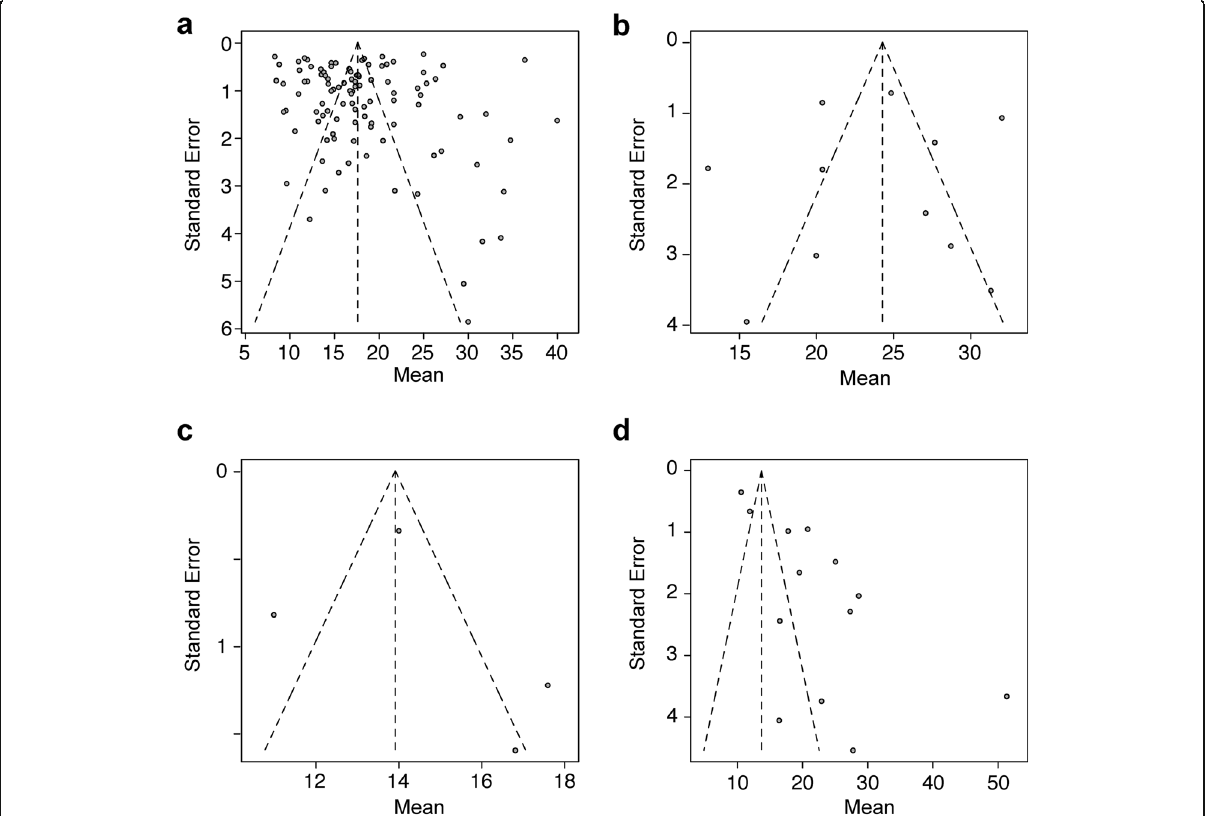
Fig. 2 The funnel plots of the duration of SARS-CoV-2 RNA positivity in various samples. The funnel plots of the duration of SARS-CoV-2 RNA positivity in the upper respiratory tract samples ( a ), the sputum ( b ), the blood ( c ), and the stool ( d ) were